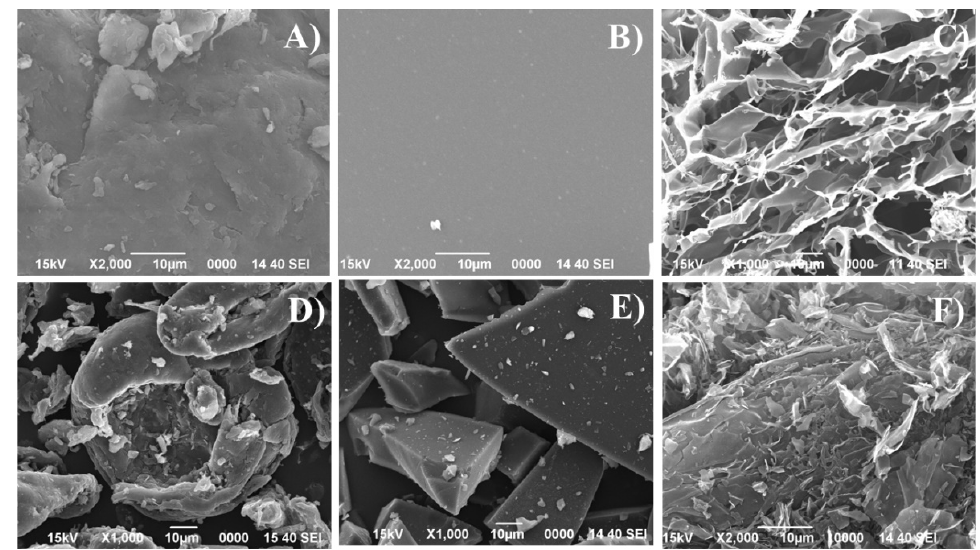
Figure 3. SEM images of Chi-P ( A ), Chi-F ( B ), Chi-G ( C ) and their respective samples pyrolyzed at 900 °C: Chi-P-900 ( D ), Chi-F-900 ( E ) and Chi-G-900 ( F ). (Scale: 10 μ m).